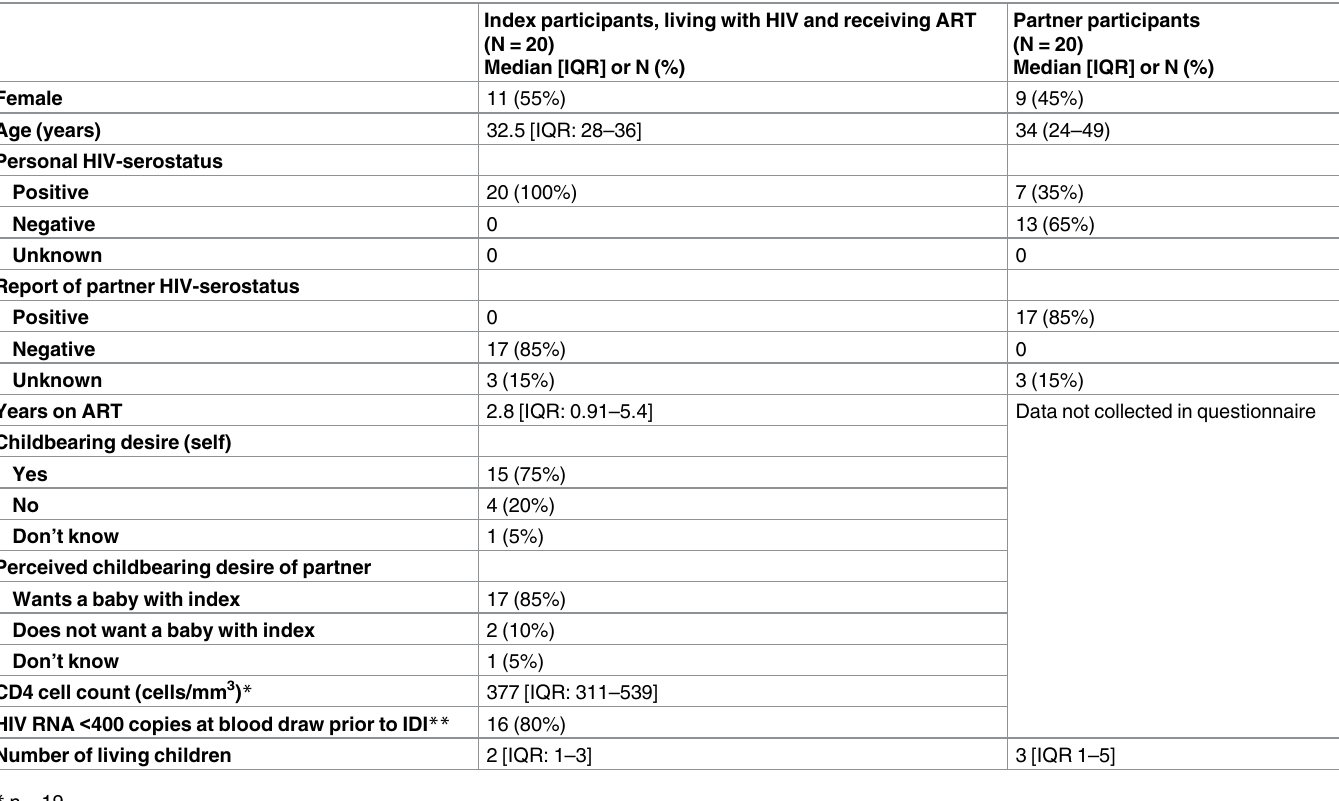
Table 1. Socio-demographic data from index and partner